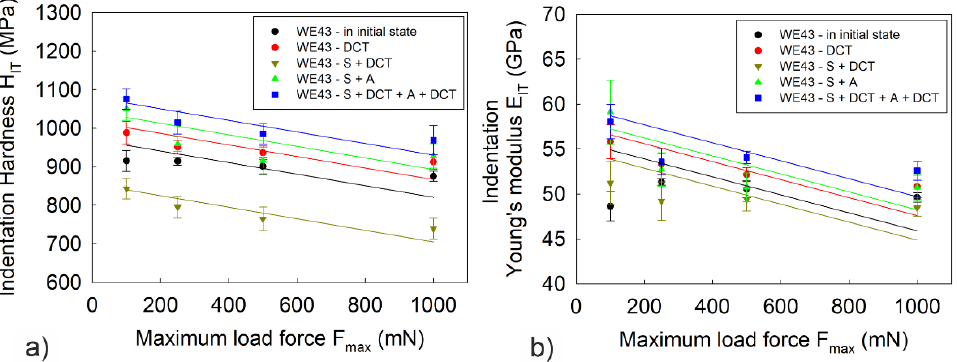
6 of 15 Figure 3. Load–unload curves F(h) for alloy WE43 in its initial state ( a ) , after deep cryogenic treat-